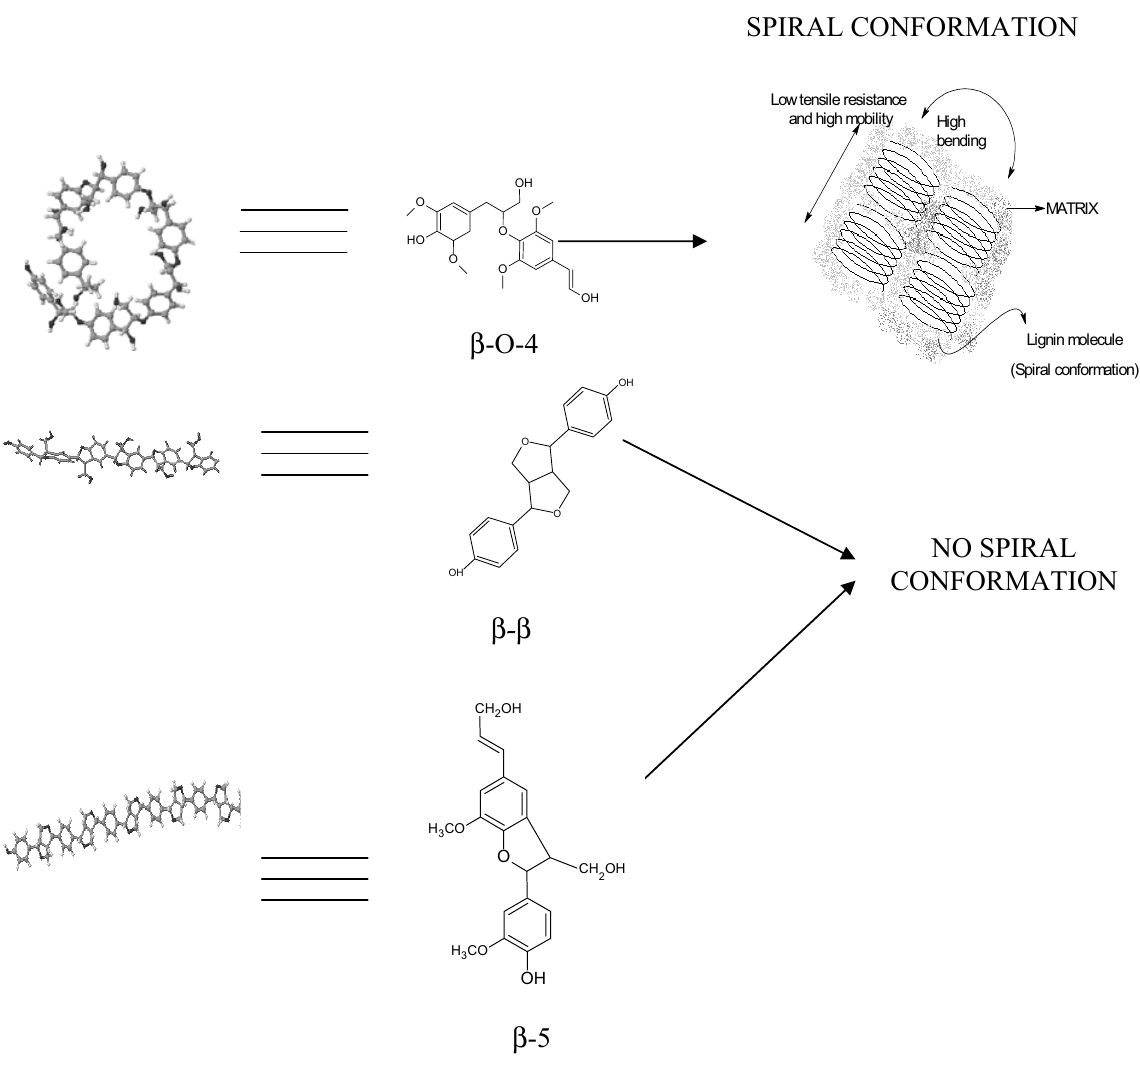
Fig. 2 – Proposal of a structural profile of lignin molecule with β -O-4, β - β , β -5, respectively (first figure) and (second